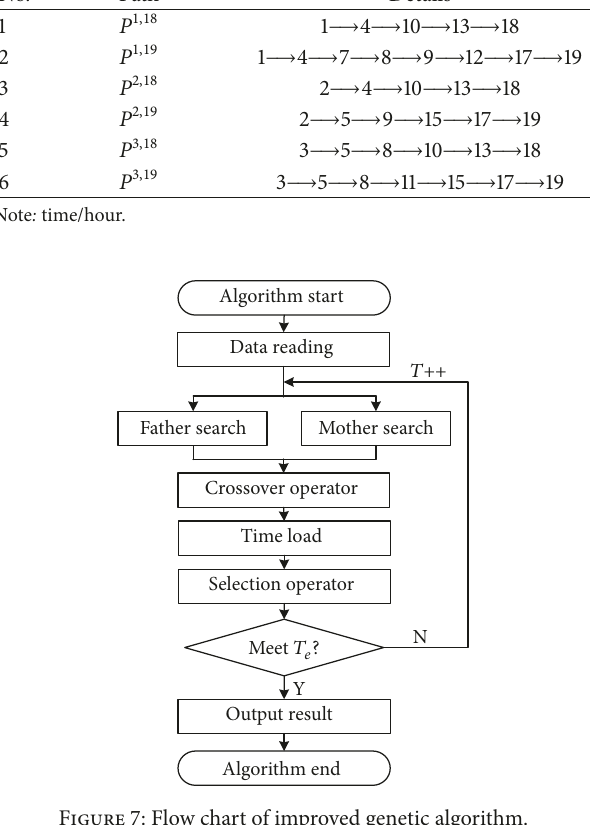
Figure 7: Flow chart of improved genetic algorithm.